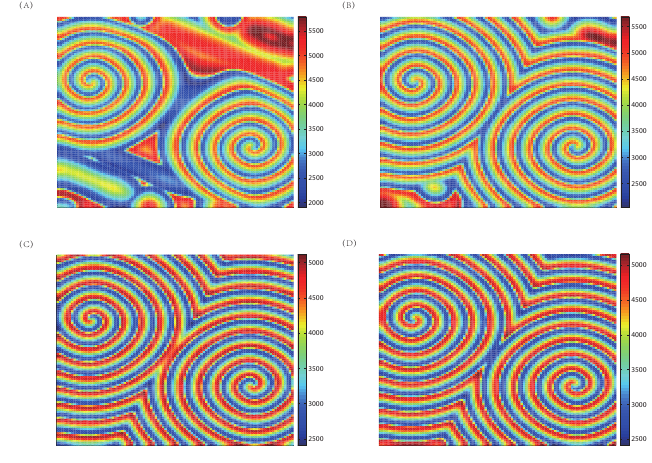
Figure 2. Example spatial patterns (snapshots of two spiral wave at different time for (A) t=400, (B) t=600, (C) t=800, (D) t=1000).